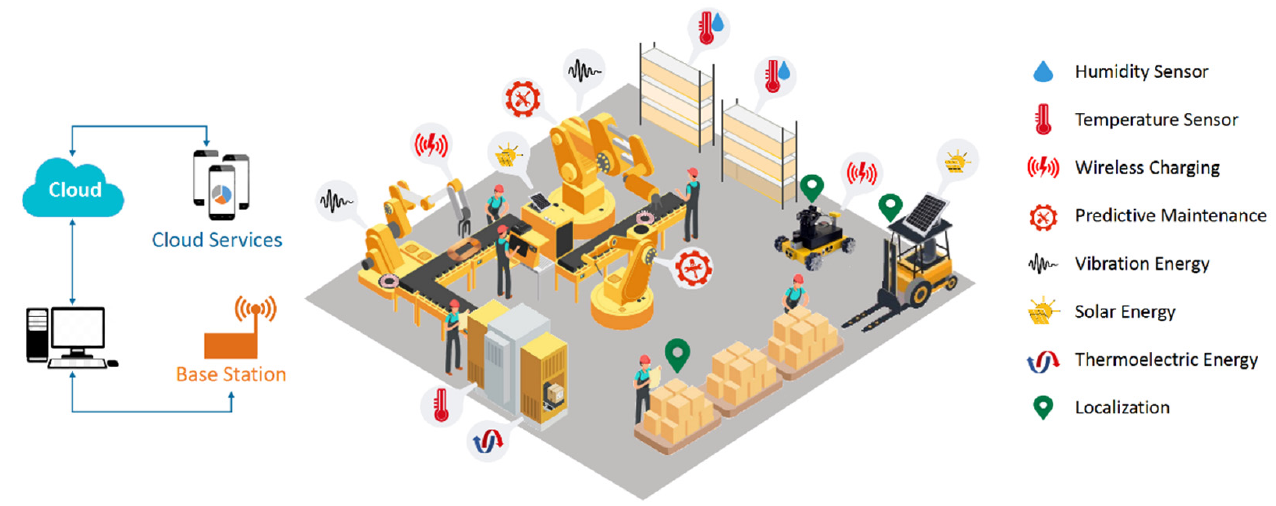
Figure 2. Power-aware wireless sensor networks in industrial environment.